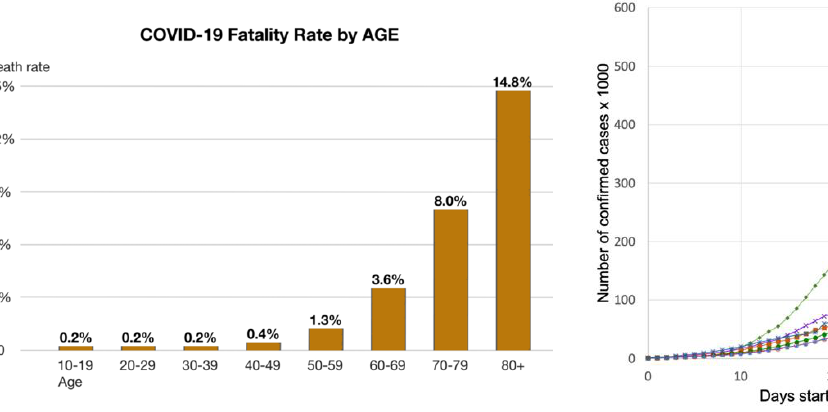
Figure 1. Case fatality rates by age group in China. Data through 11 February 2020.